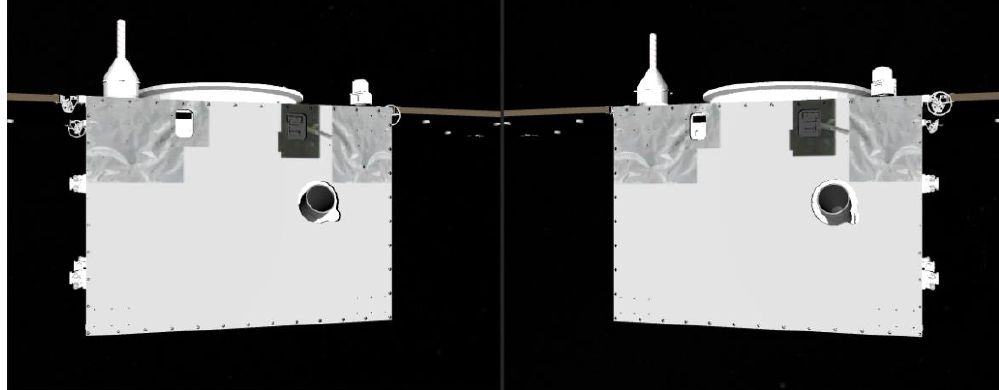
Figure 13. Convergence binocular images simulated from Unity (left: from the left camera, right: from the right camera).